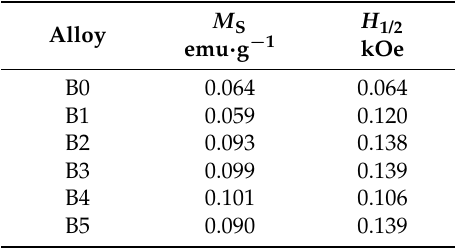
Figure 9. Magnetic susceptibilities of alloys in this study. Table 7. Summary of the RT magnetic properties ( M S : saturated magnetic susceptibility and H 1/2 : applied field at half of the M S value).